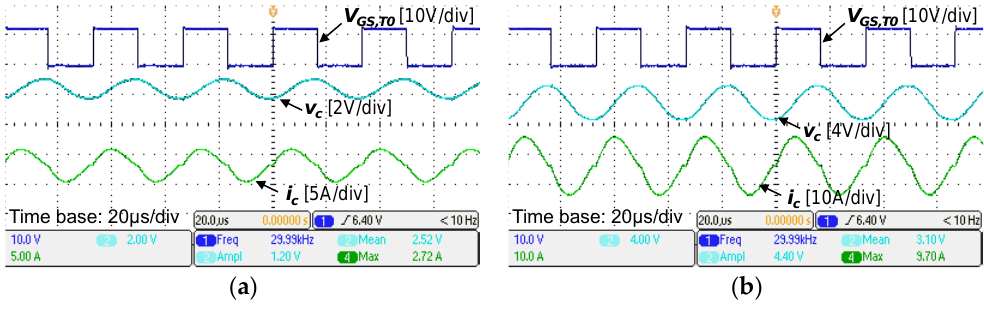
Figure 16. Measured voltage and current waveforms of the switch-capacitor and the gate-source voltage of T 0 . ( a ) With an input source voltage of 3.4 V; ( b ) with an input source voltage of 5 V.